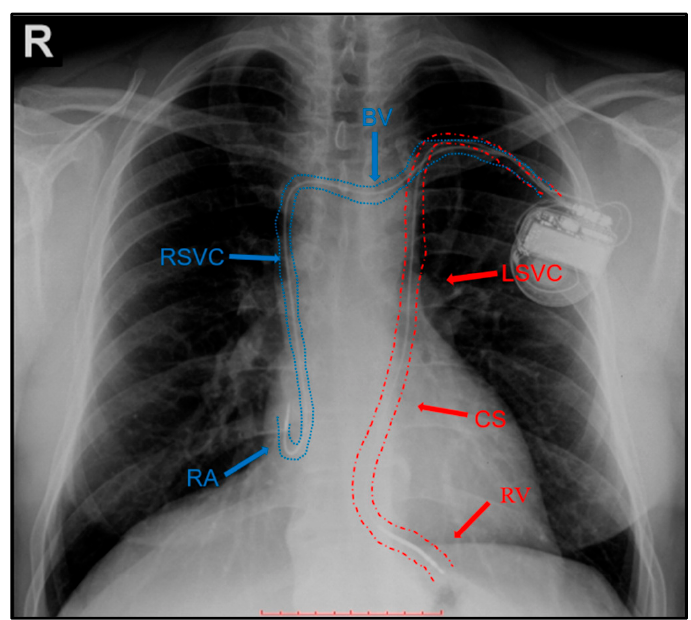
Figure 3. The defibrillation lead can be seen on the trajectory of the left superior vena cava (LSVC), through the coronary sinus (CS) into the right ventricular apex (RV)—red arrows. The atrial lead can be seen through the brachiocephalic vein (BV), right superior vena cava (RSVC) into the right atrial appendage (RA)—blue arrows.